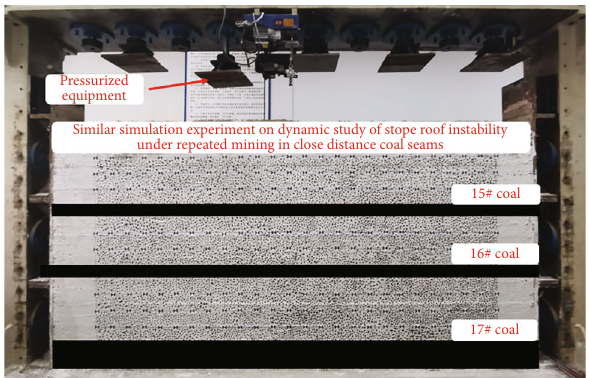
Figure 4: Initial model.